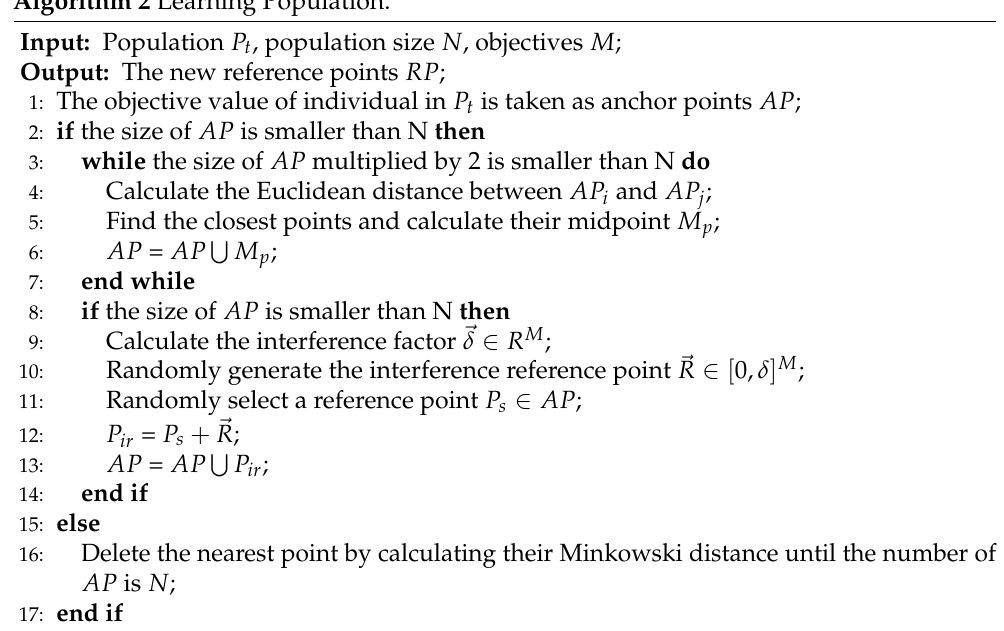
Algorithm 2 Learning Population.